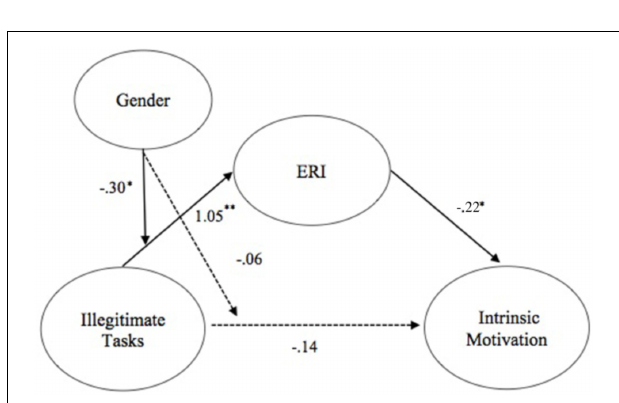
FIGURE 2 | Tested moderated mediation model for illegitimate tasks and intrinsic motivation. Solid paths represent significant links found. Dashed paths represent links that were hypothesized but non-significant. Parameters represent unstandardized beta coefficients, ∗ p < 0.05, ∗∗ p <